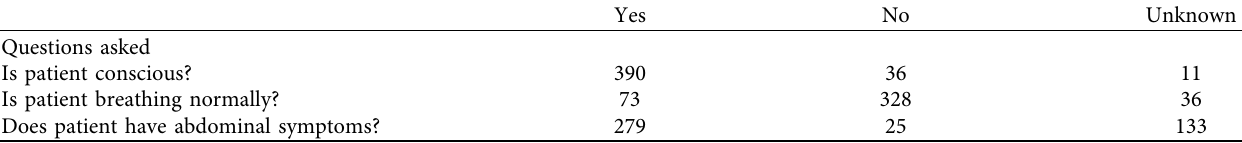
Table 2: Performance of dispatchers’ interviews for calls consistent with anaphylaxis ( N �